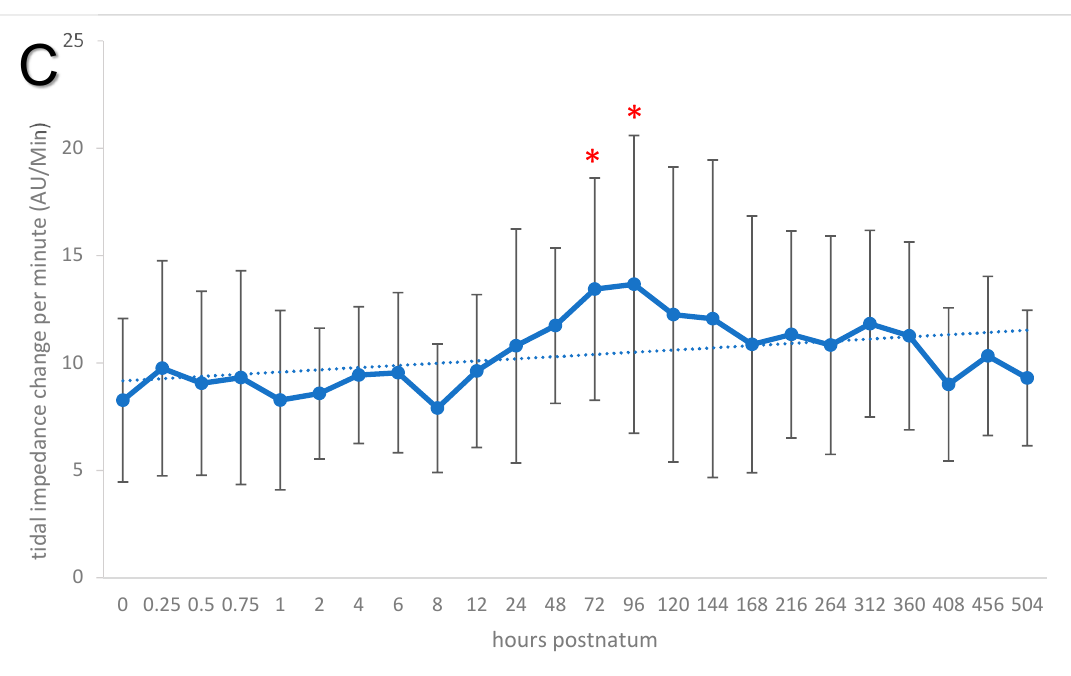
Figure 6. ( A ) Means and standard deviations of the respiratory rate (solid line) and trend line (dotted) in 20 neonatal calves. The measuring times are graphed equidistantly. Values with an asterisk differ from the value at time 0. ( B ) Means and standard deviations of the tidal impedance change (solid line) and trend line (dotted) in 20 neonatal calves. The measuring times are graphed equidistantly. Values with an asterisk differ from the value at time 0. ( C ) Means and standard deviations of the minute tidal impedance change (solid line) and trend line (dotted) in 20 neonatal calves. The measuring times are graphed equidistantly. Values with an asterisk differ from the value at time 0. Mean Δ ZVT was 0.25 ± 0.09 AU, and significant increases were seen during the study